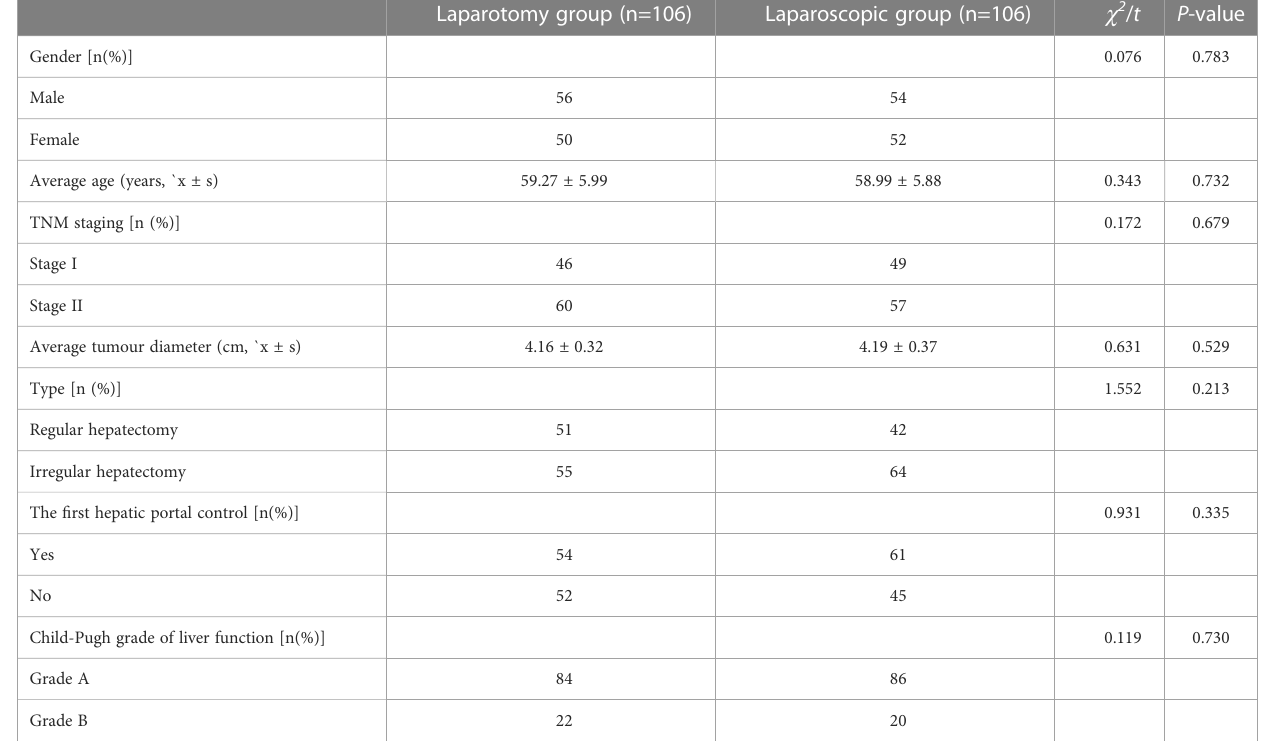
TABLE 1 Comparison of general baseline data between the two